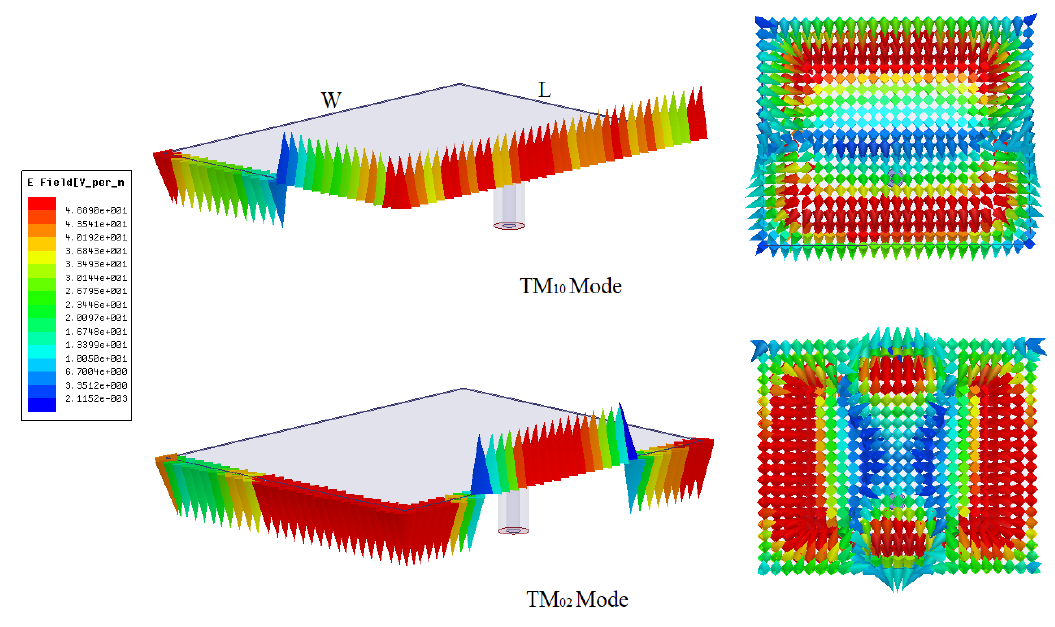
Figure 1. Electric field vectors in dominant TM 10 and orthogonal TM 02 modes (2.1 GHz). The electric field variation along the length and width, and into the substrate is shown in Figure 1.